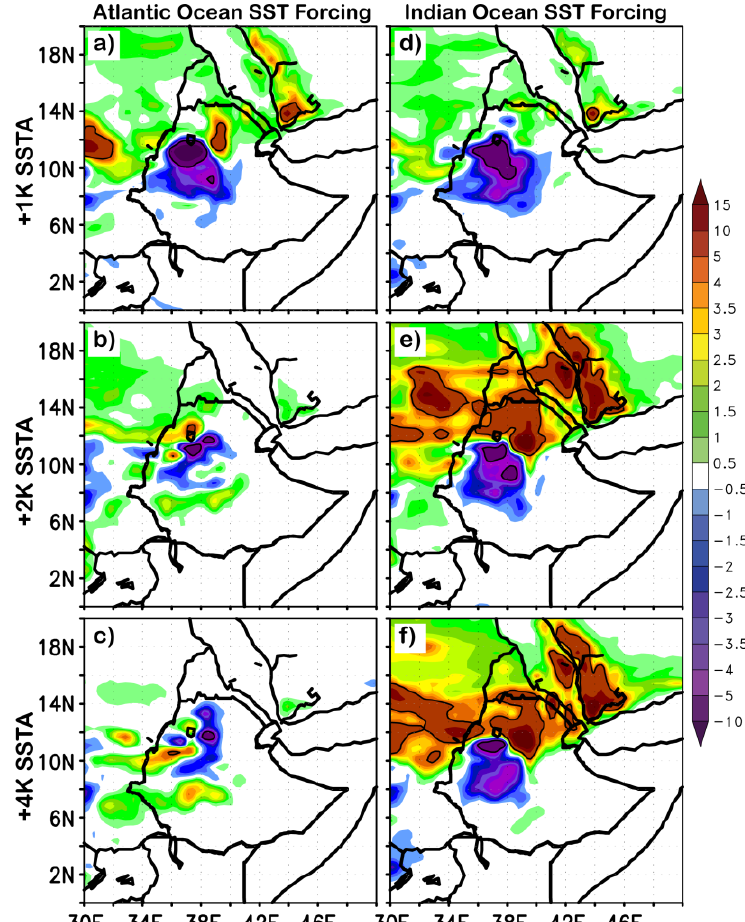
Figure 9. Rainfall rate differences (mm·day −1 , color scale at right) from CNTRL averaged over July–August for simulations with ( a ) +1K sea surface temperature anomaly (SSTA) forcing over the Atlantic Ocean (AT; 40°S–35°N, 30°W–15°E), ( b ) 1K SSTA forcing over the Indian Ocean (IO; 40°S–25°N, 30°–110°E), ( c ) +2K SSTA forcing over AT, ( d ) +2K SSTA forcing over IO, ( e ) +4K SSTA forcing over AT, and ( f ) + 4K SSTA forcing over IO. Differences of ±5 mm·day −1 rainfall rates are contoured. See Table 1 for description of